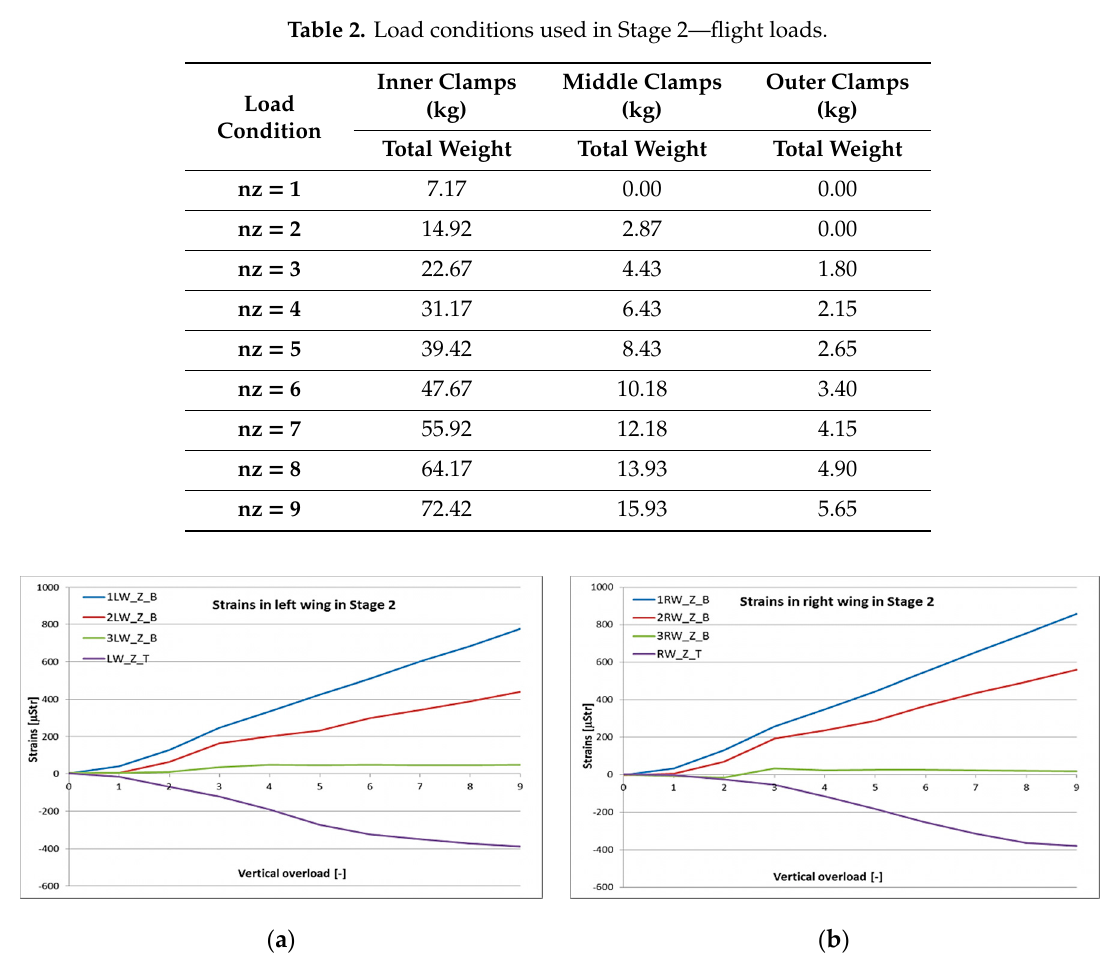
Figure 17. Strain measured in the ( a ) left and ( b ) right wing (bending in the Z -axis and torque) during Stage 2.